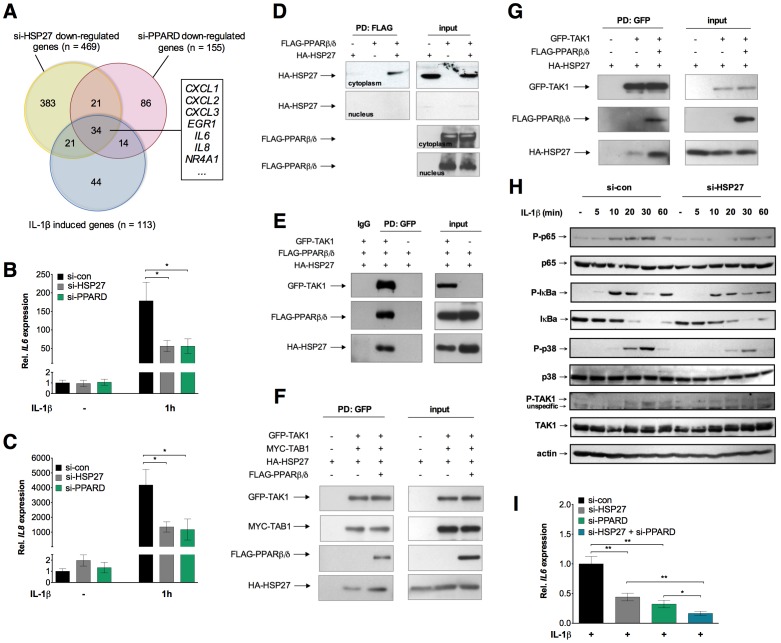
Functional and physical interaction of PPARβ/δ with HSP27.(A) Venn Diagram showing the overlaps of genes induced by IL-1β (blue; threshold ≥2-fold; n = 34; n = 113), downregulated by si-HSP27 (yellow; threshold ≥1.5-fold; n = 469) or downregulated by si-PPARD (red; threshold ≥1.8-fold; n = 155). HeLa cells were treated with control siRNA (si-con) or gene-specific siRNAs followed by IL-1β (10 ng/ml) for 1 h (see Figure S1 and S8 for knockdown efficiency). Expression patterns were determined by microarray analyses and genes showing a ≥1.5-fold regulation were identified (Dataset S4). The observed regulation was verified by RT-qPCR, as exemplified for the genes listed in the boxed areas and shown in Figure S9. (B, C) Effect of HSP27 or PPARβ/δ depletion on the IL-1β-mediated induction of the IL6 (B) and IL8 (C) genes in HeLa cells determined by RT-qPCR. Values represent averages ±SD (n = 3). ***, **, *significant difference between si-con and si-PPARD-treated cells (p<0.001, p<0.01, p<0.05 by t-test). (D) Cytoplasmic interaction of PPARβ/δ and HSP27 detected by co-immunoprecipitation. HEK293T cells were transfected with expression vectors for HA-tagged HSP27 and/or FLAG-tagged PPARβ/δ. Cells were fractionated into cytoplasmic and nuclear fractions, pulldown (PD) was carried out with an antibody against FLAG and immunoblotting with anti-HA antibodies. (E) Immunoprecipitation of GFP-tagged TAK1 in complexes with FLAG-tagged PPARβ/δ, HA-tagged HSP27. HEK293IL-1R cells were transfected with the indicated expression vectors. Pulldown (PD) was carried out with an antibody against GFP, and immunoblotting with antibodies against TAK1, FLAG or HA. (F) Co-expression of PPARβ/δ enhances the interaction of HSP27 and TAK1. HEK293IL-1R cells were transfected with expression vectors for GFP-tagged TAK1, MYC-tagged TAB1, HA-tagged HSP27 and FLAG-tagged PPARβ/δ. Pulldown (PD) was carried out with an antibody against GFP, and immunoblotting with antibodies against TAK1, TAB1, FLAG and HSP27. (G) Same experiment as in panel F, except that MYC-TAB1 was omitted. (H) Immunoblot analysis of the indicated proteins at different time points after IL-1β stimulation of si-con and si-HSP27 treated HeLa cells. Details as in Figure 5B. The siRNA effect on HSP27 protein levels in this experiment is shown in Figure S8. (I) Effects of siRNA-mediated depletion of PPARβ/δ or/and HSP27 on the IL-1β-induced transcription of IL6 (6 h stimulation with IL-1β). Values represent averages ±SD (n = 3). ***, **, *significant differences (p<0.001, p<0.01, p<0.05 by t-test).